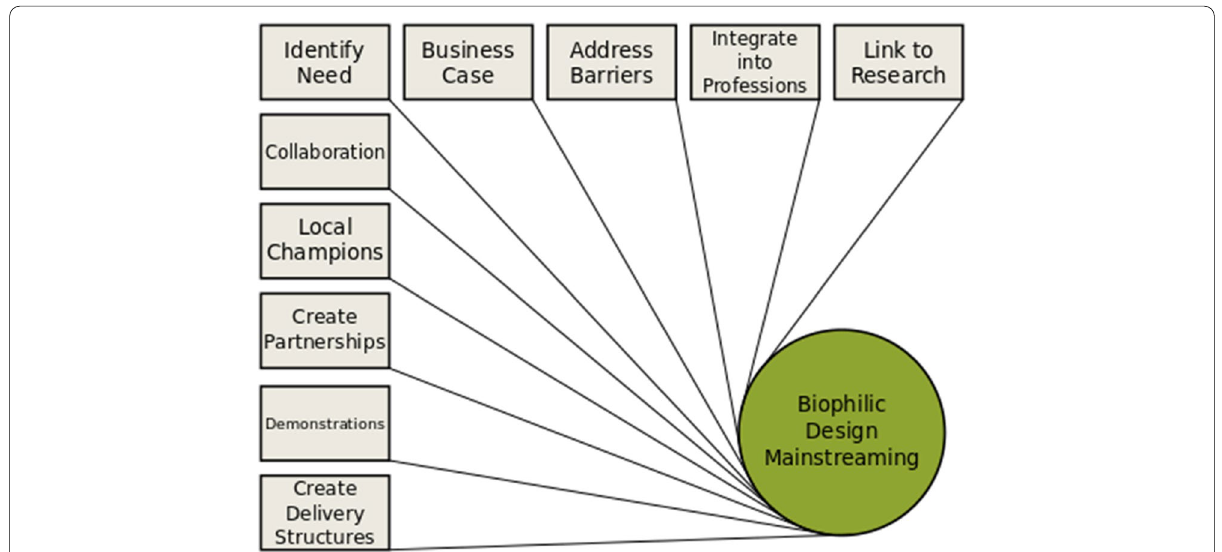
Fig. 4 Ten actions for mainstreaming biophilic design as a social movement. (Source